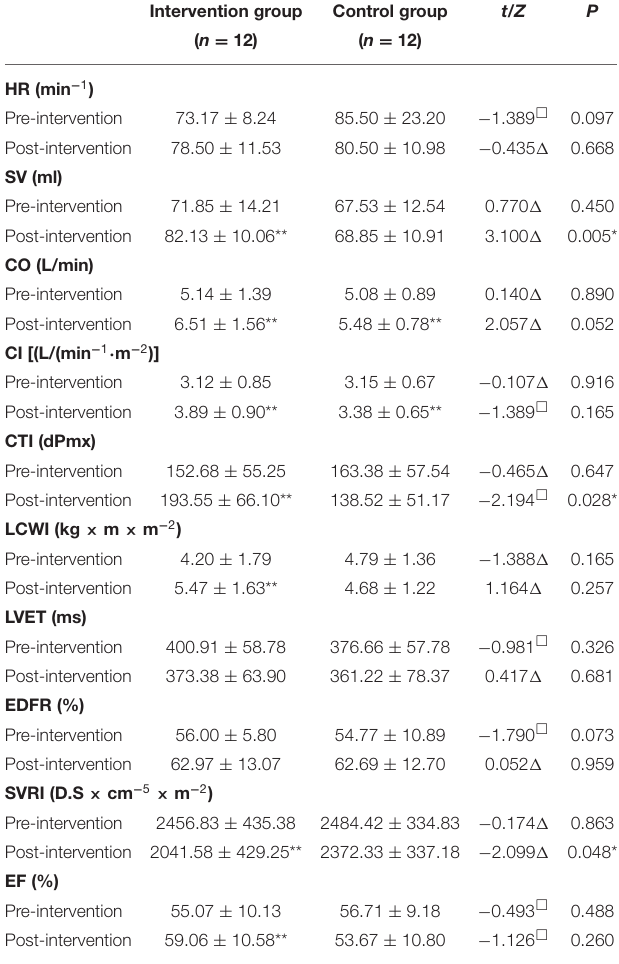
TABLE 3 | Non-invasive cardiac output at rest (x ± s). Intervention group Control